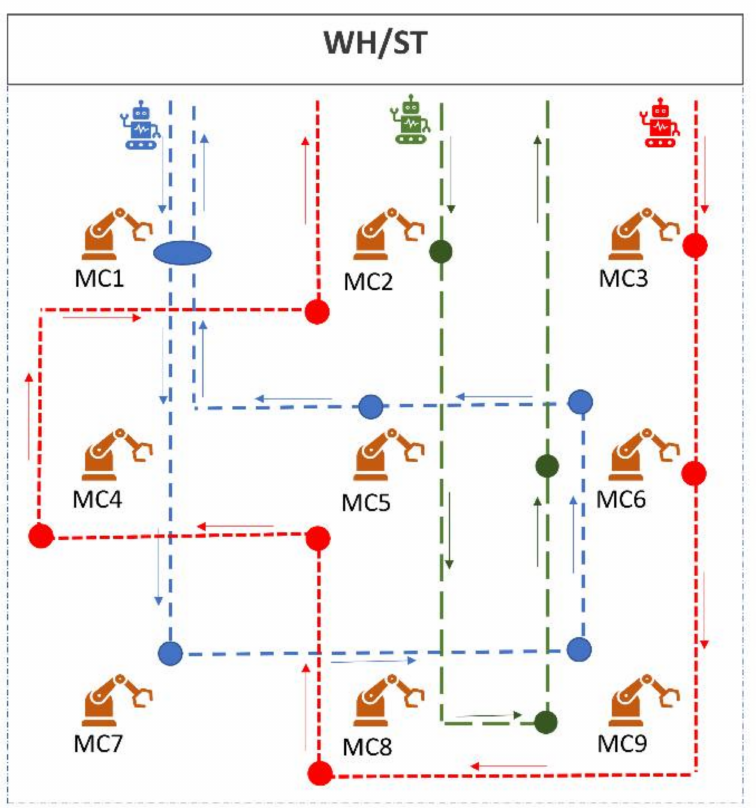
Figure 7. Three optimized in-plant supply routes in the matrix grid optimized with flower pollination- based heuristics.